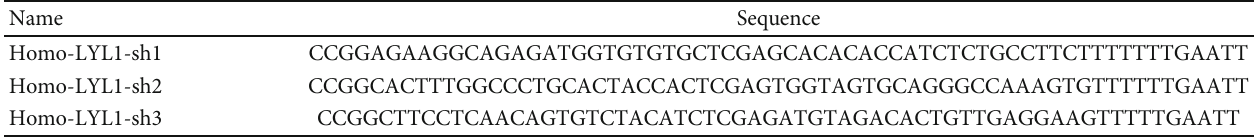
Table 1: shRNAs used to knock down LYL1.